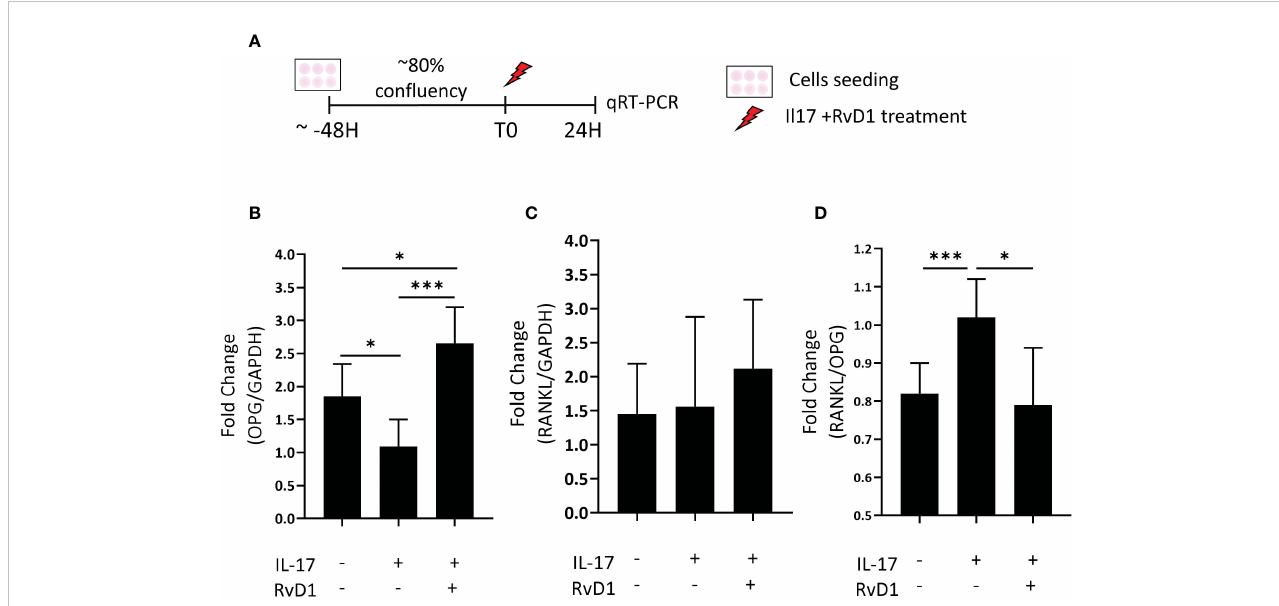
FIGURE 4 RvD1 increased OPG and decreased the RANKL : OPG ratio expression in fl ammatory conditions in vitro. (A) MC3T3E-1 pre-osteoblasts were stimulated with IL-17 (50 nM) with and without RvD1(200 nM) for 24 hours. RNA was extracted from cells followed by RANKL, and OPG mRNA evaluation by qRT- PCR. Unstimulated cells were analyzed as an experimental control group. (B) OPG mRNA expression in cells normalized to stimulated cells without RvD1 treatment. (C) RANKL mRNA expression in cells normalized to stimulated cells without RvD1 treatment. (D) RANKL/OPG ratio mRNA expression in cells normalized to stimulated cells without RvD1 treatment. The asterisk symbol represents a statistical signi fi cance *<0.05; ***<